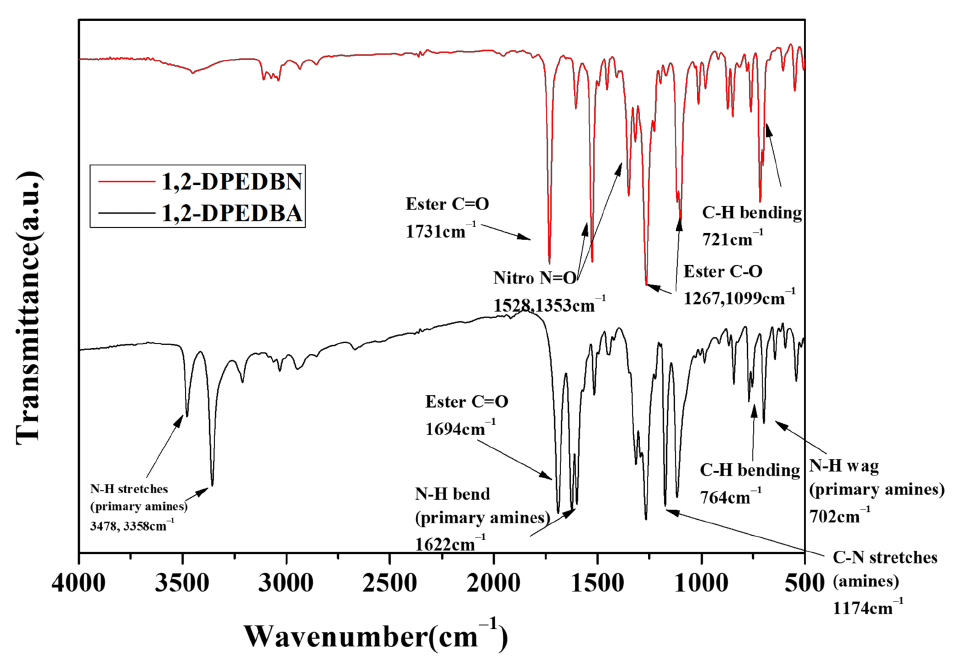
Figure 4. FT-IR spectra of 1,2-DPEDBN and1,2-DPEDBA.